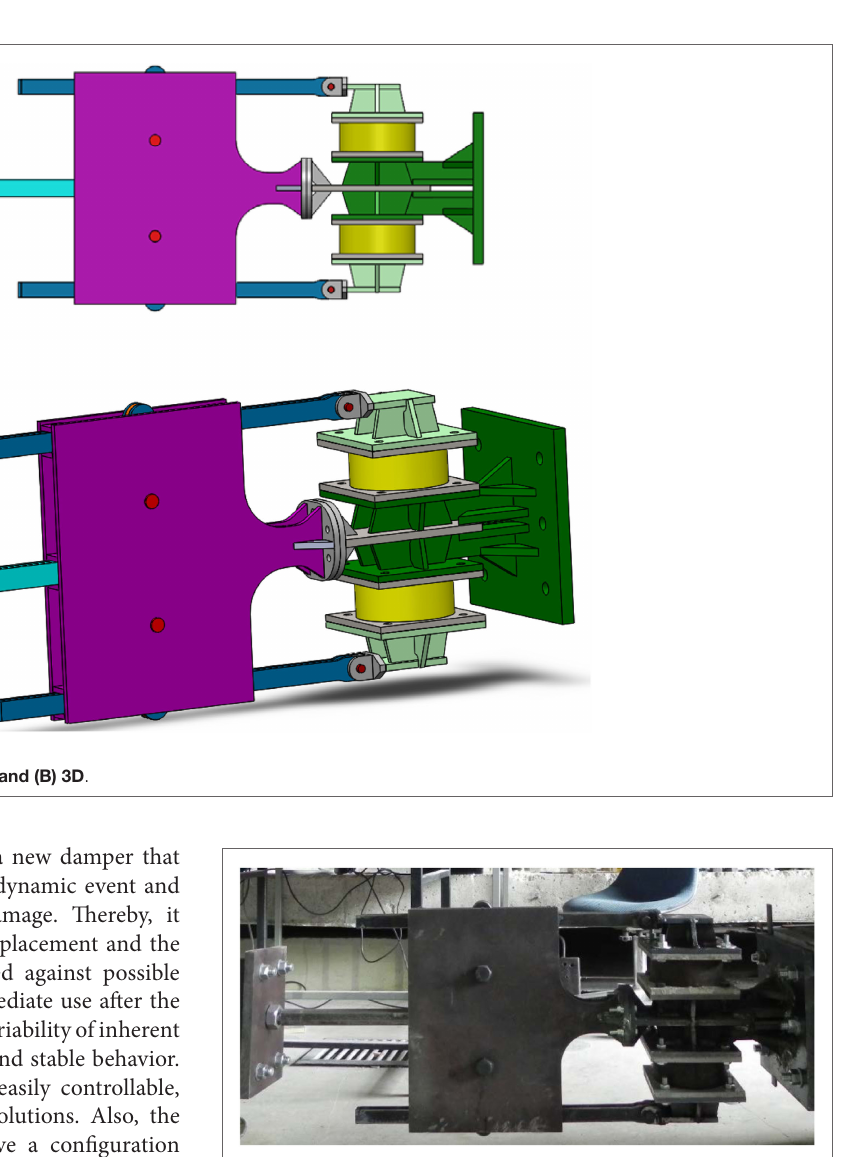
FigUre 2 | First full-scale prototype produced